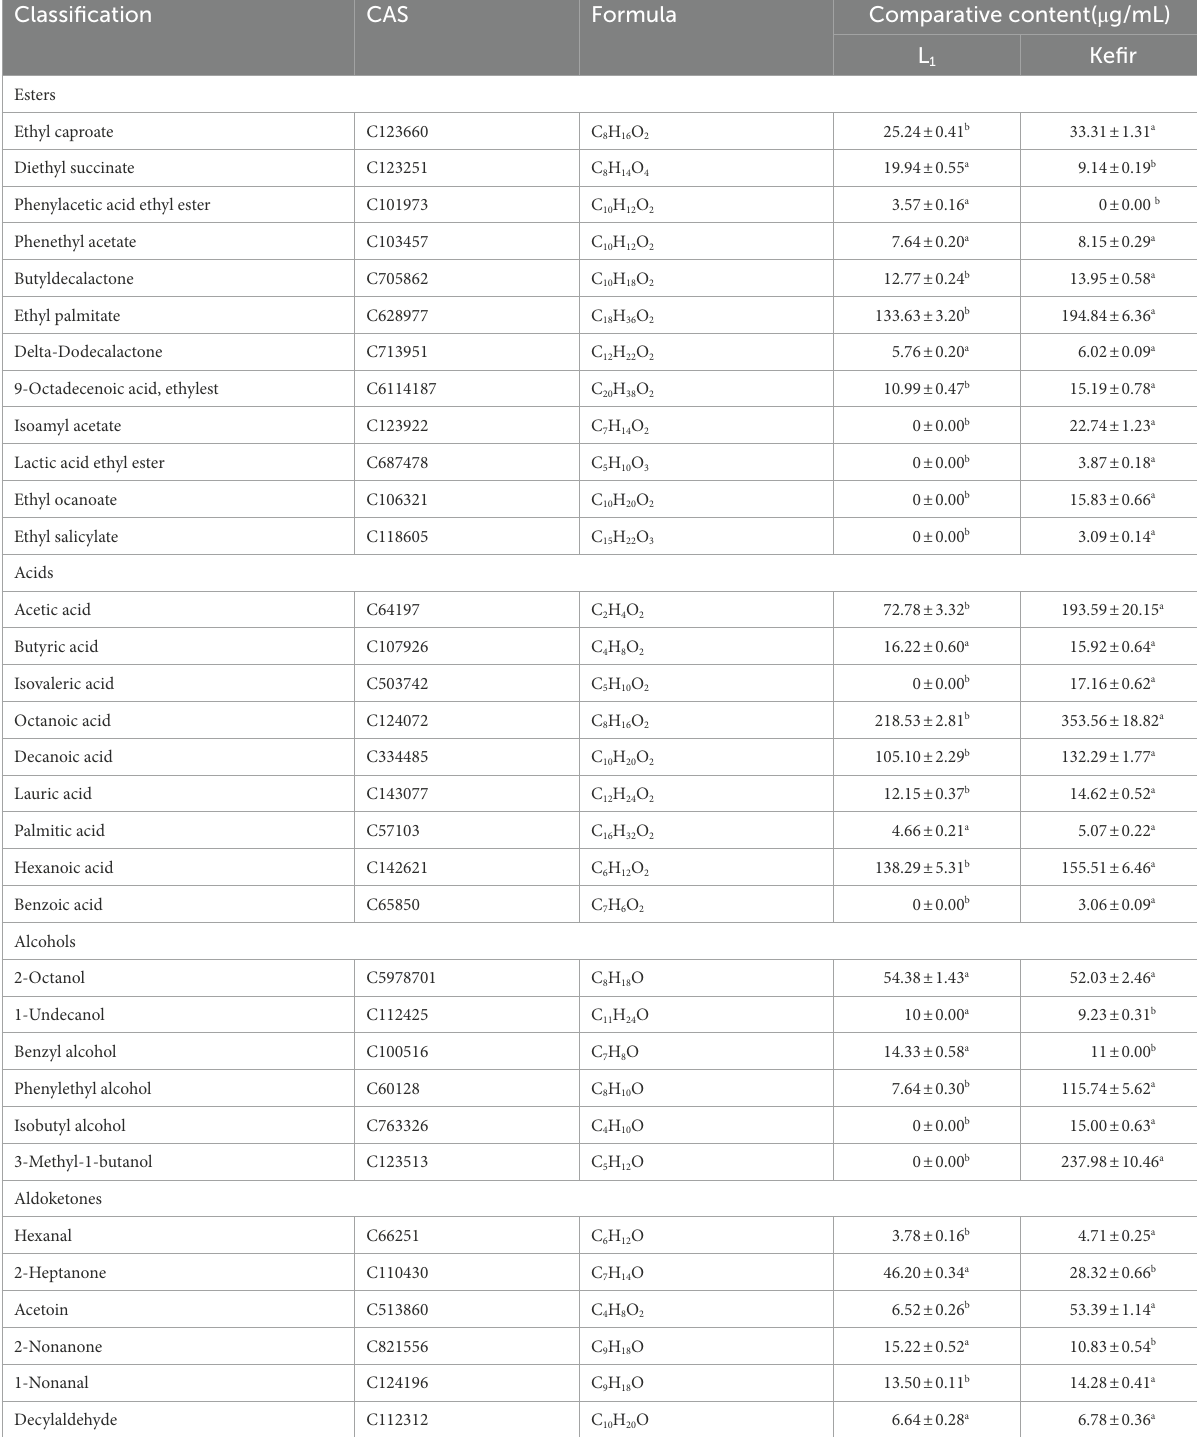
TABLE 5 Determination of volatile flavor compounds of L 1 and kefir by